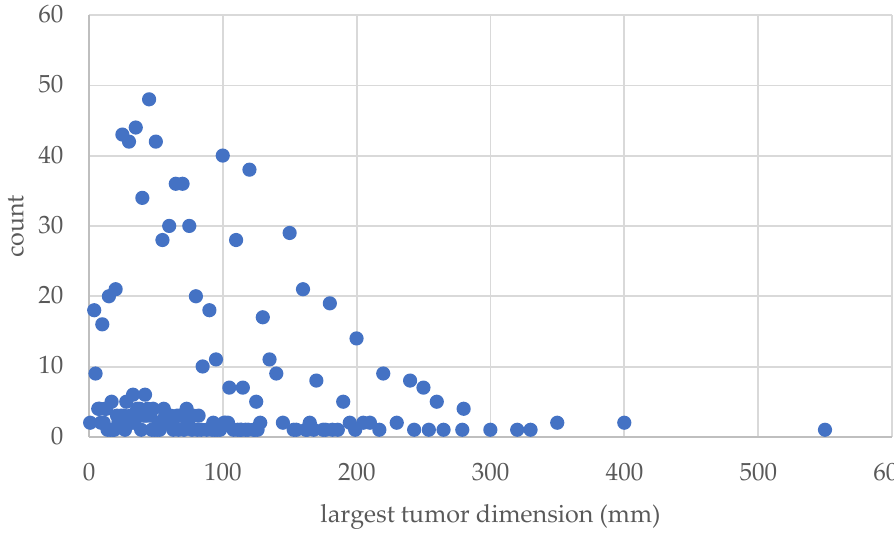
Figure 5. This diagram shows the number and size of the tumors.